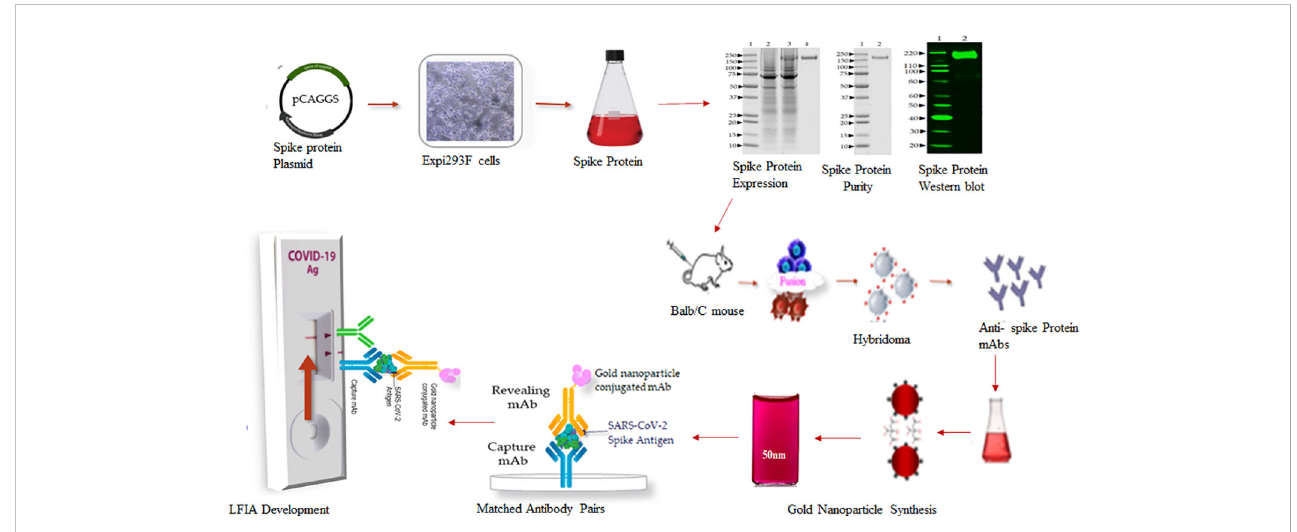
FIGURE 1 Schematic work fl ow for the development of SARS-Covid-2